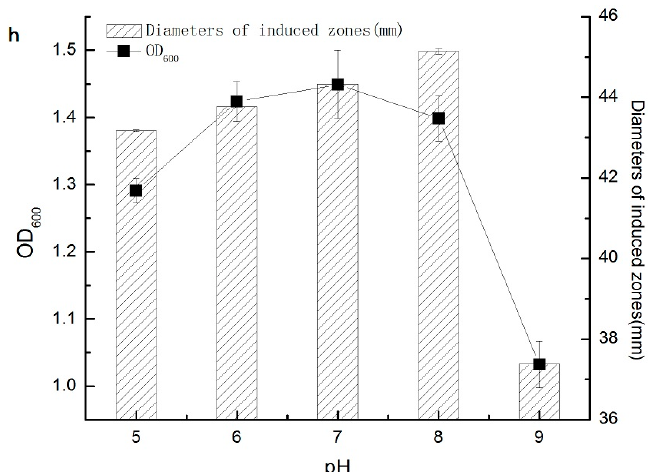
Figure 3. Relationship between growth kinetics and short chain AHL secretion under different culture time of strain AS7 and effect of different conditions on short chain AHLs production by AS7 ( a ): Agar well diffusion assay to detect AHLs secretion under different culture time; ( b ): the graph of relationship between kinetics and AHLs; ( c , d ): NaCl concentration 0: blank control, 1: NaCl 0.5%, 2: NaCl